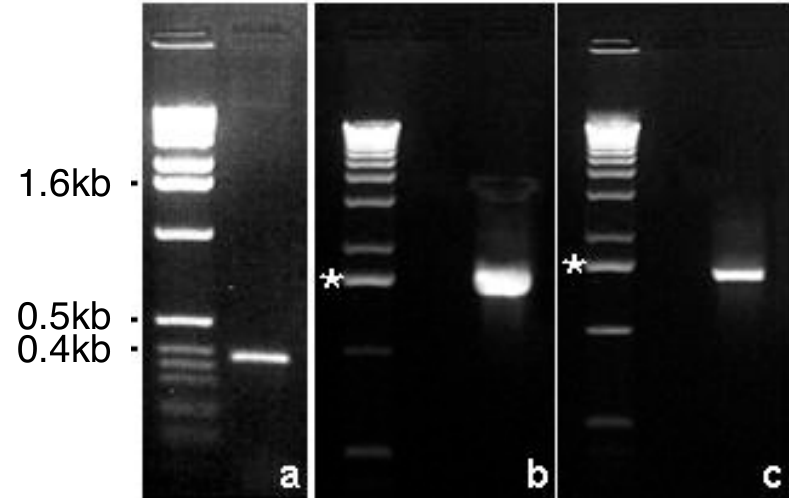
Figure 1. PCR on genomic Dna. a. Degenerate primers EP1-EP3 (mw 383 bp). b. EPF-EPR primers specific for coding region (mw 1624 bp). c. PREPF-PREPR primers specific for promoter region (mw 1343 bp). Left lane (each gel) DNA mw marker: 1 kb ladder (gibCo-bRl); in b and c: * 1.6